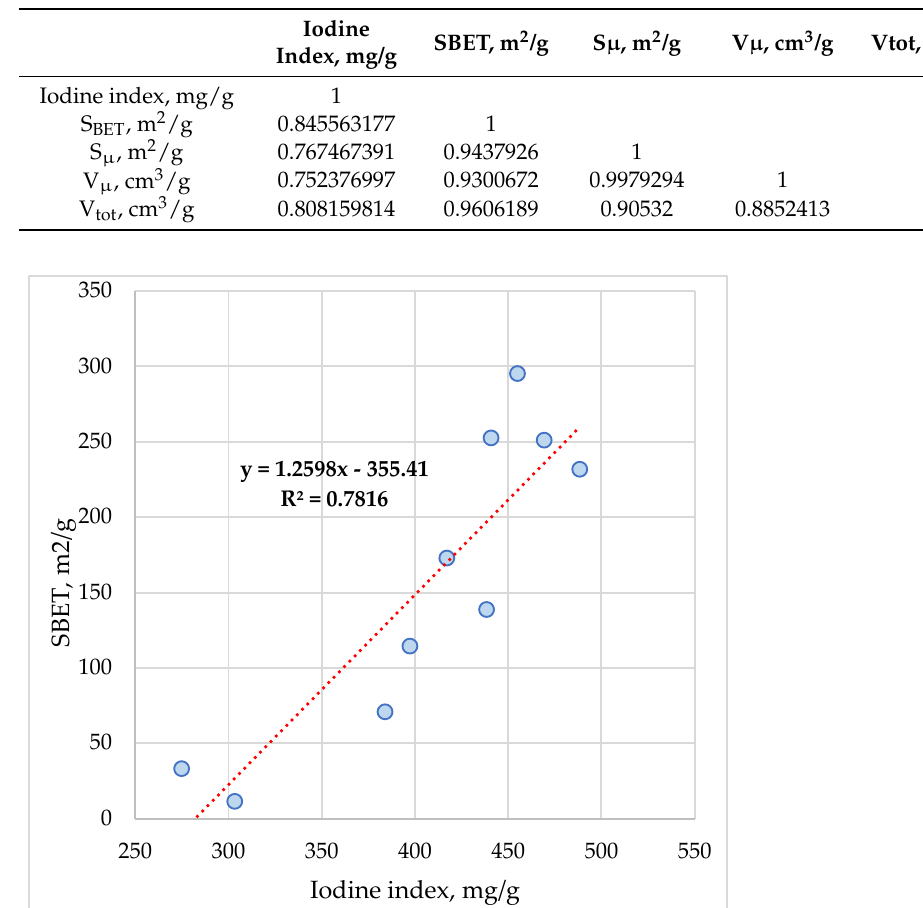
Table 5. Statistical parameters for the porosimetric characteristics determined by SBET analysis.